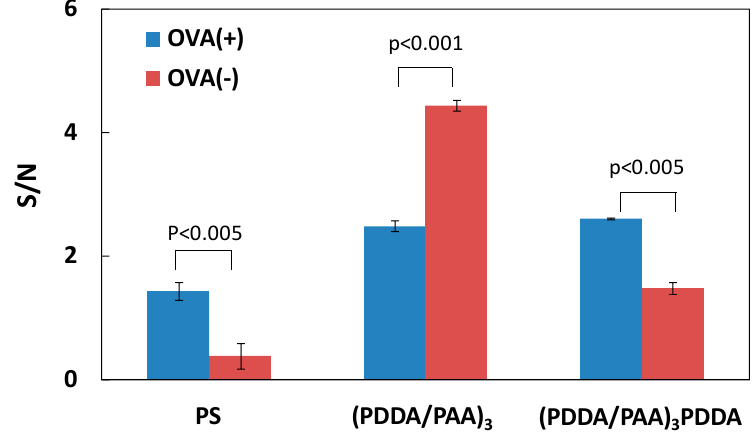
Figure 4. S/N ratio for antigen detection with, and without, OVA adsorption on the PS plate, (PDDA/PAA) 3 , and (PDDA/PAA) 3 PDDA ( n = 3).